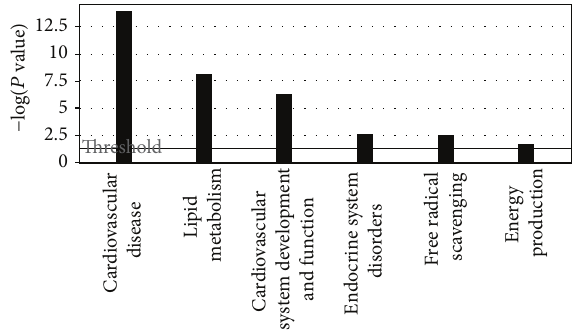
Figure 5: Top biofunctional processes associated with the differen- tially expressed proteins generated by